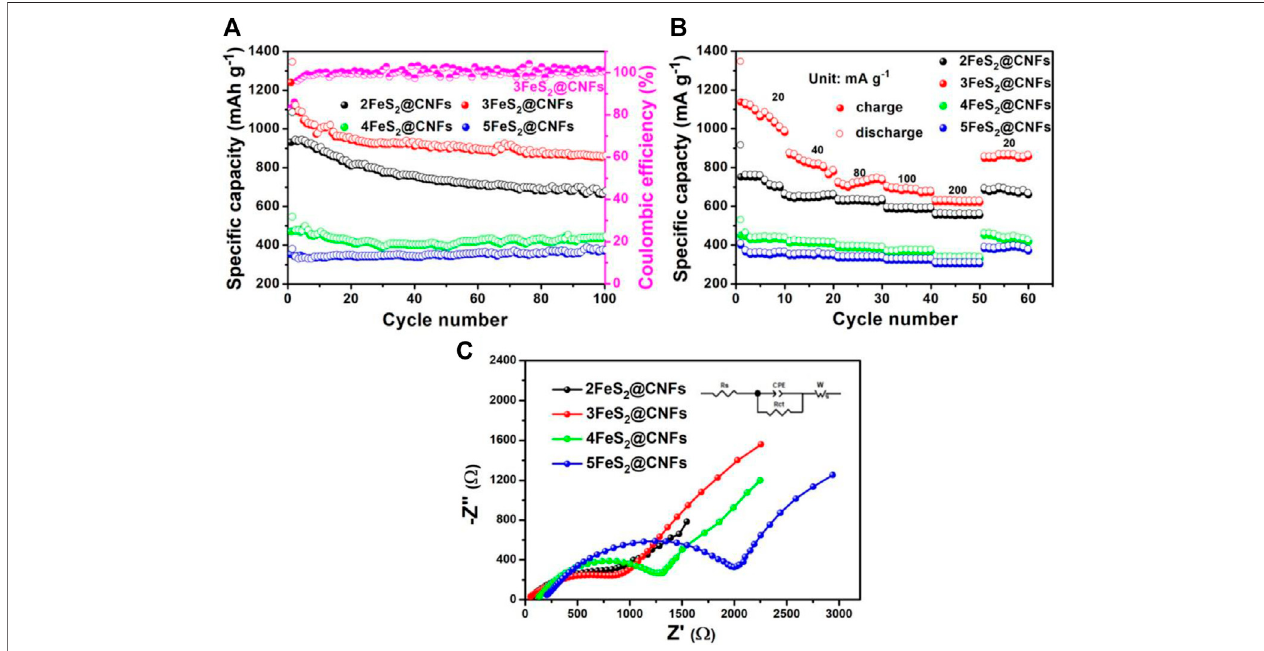
FIGURE 9 | (A) Cycling performance at 20 mA g − 1 , (B) rate performance, and (C) EIS plots of the different electrodes.